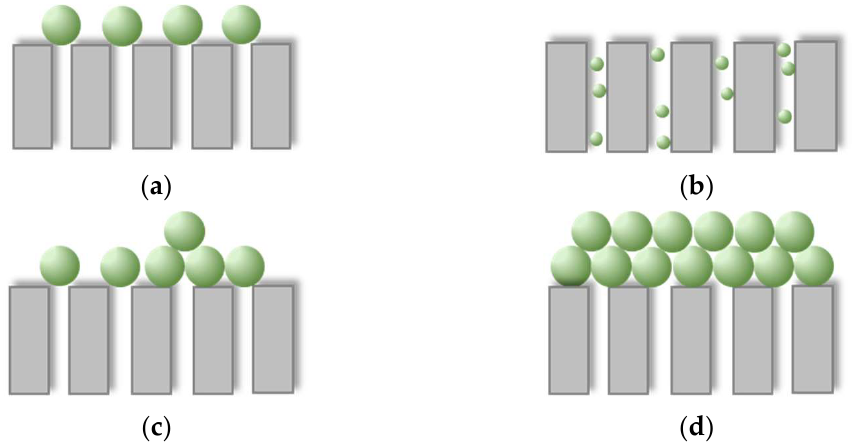
Figure 3. The fouling mechanisms: ( a ) complete blocking; ( b ) standard blocking; ( c ) intermediate blocking; ( d ) cake layer. Based on [86,126,128,130].